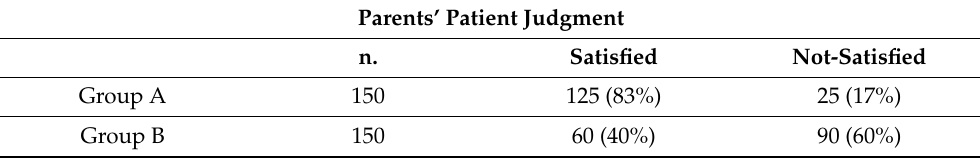
Table 3. Distribution of parents’ patient